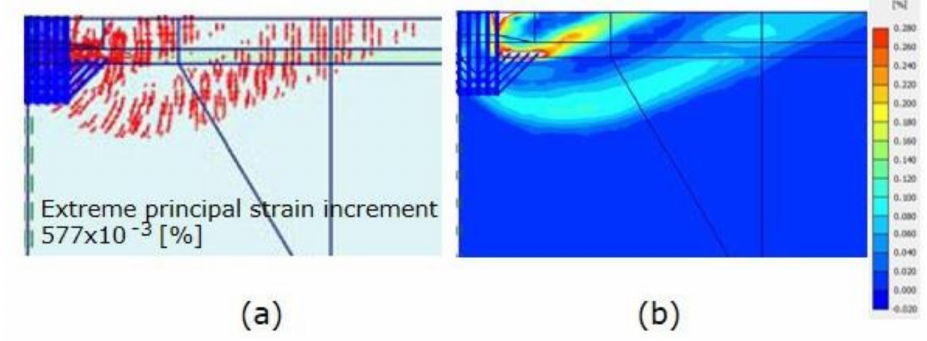
Figure 12. Incremental strains for the case in which the sand has ϕ (cid:48) 1 = 40 ◦ and ψ (cid:48) 1 = 40 while the weak layer is characterised by ϕ (cid:48) 2 = 30 ◦ and ψ (cid:48) 2 = 30; the depth of the weak layer is z i /B = 0.5. ( a ) principal directions; ( b ) shear